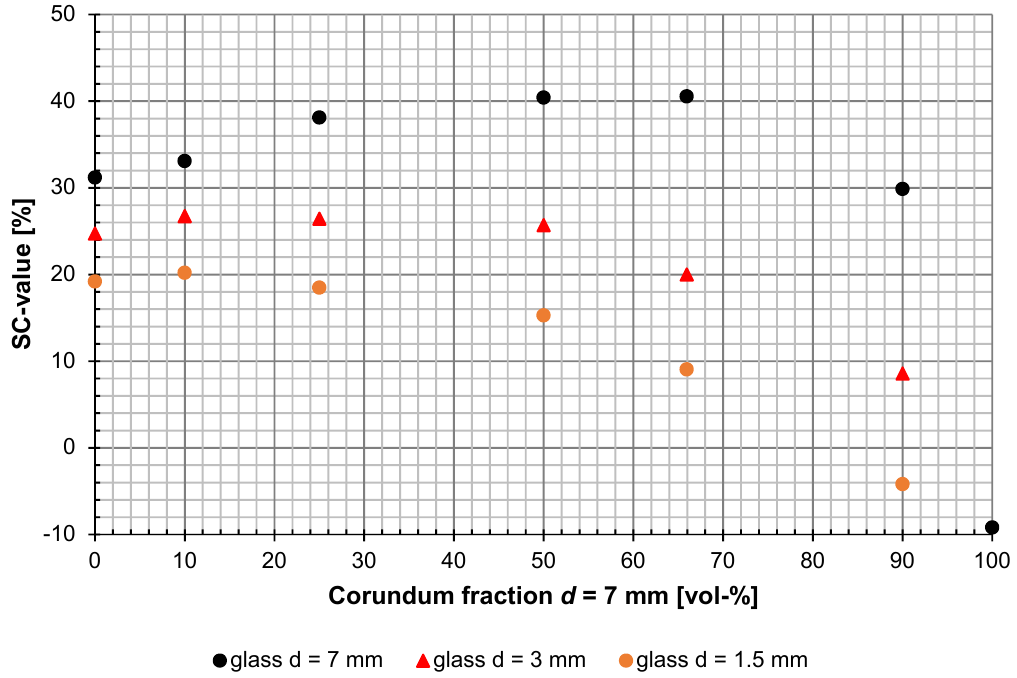
Figure 6. Selective comminution of mixtures of a corundum fraction with various glass fractions. This effect is superimposed, however, by the size–strength effect, if particles of differ- ent size fractions are mixed. The finer the glass balls are, the earlier the equilibrium point is reached, beyond which the corundum particles are preferentially comminuted. For glass balls of 3 mm diameter, this point is still beyond 90% corundum ball content in the mixture, and for 1.5 mm glass balls this point is between 66% and 90% corundum ball